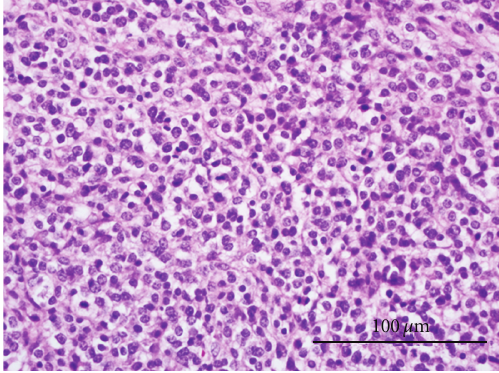
Figure 4: Fine-needle aspirate of an intra-abdominal mass in a young dog. Mildly pleomorphic round cells containing low num- bers of vacuoles and one cell with a single large vacuole are present. These cells occasionally formed loose aggregates as seen here. The primary di ff erential diagnosis was neoplasia (histiocytic sarcoma, other sarcomas, or atypical lymphoma). Wright’s—Giemsa stain, 100x objective, bar = 20 µ m.